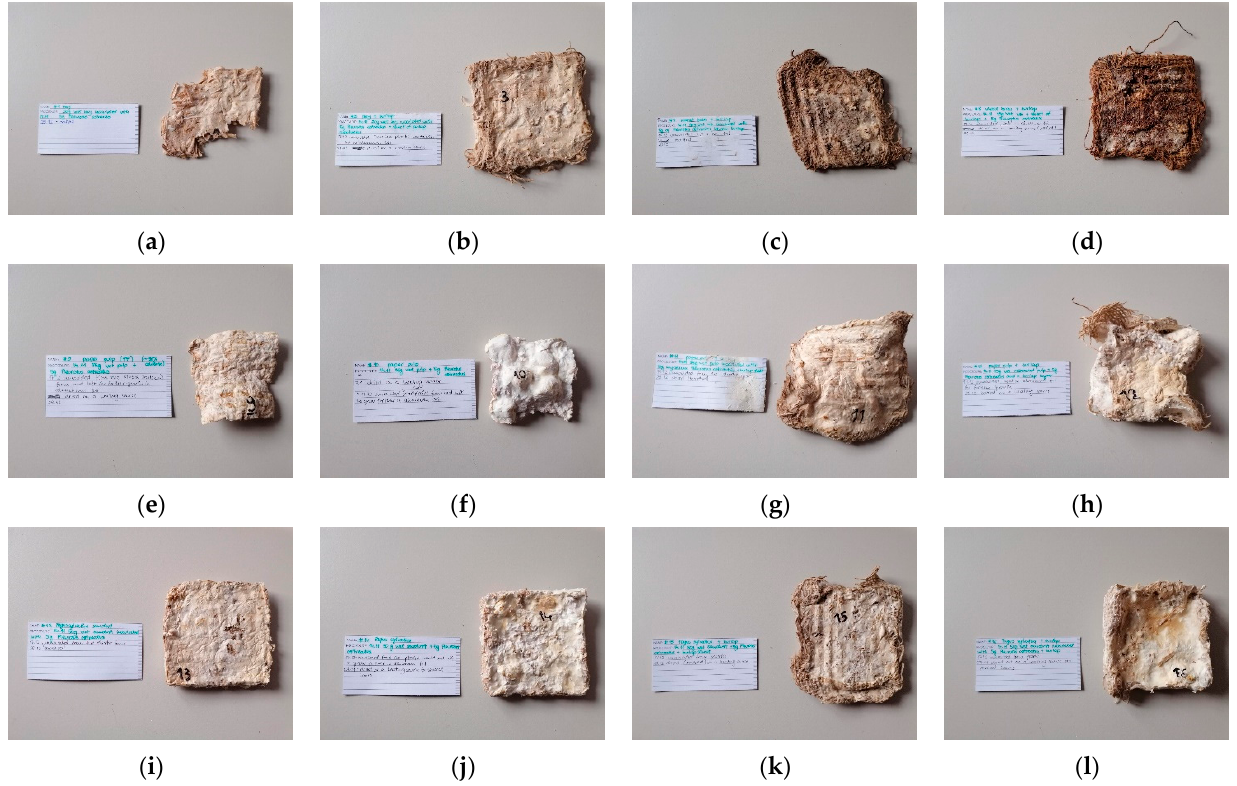
Figure 5. Samples of growth compatibility of Pleurotus ostreatus with straw, wheat bran, bleached cellulose pulp and beech sawdust: ( a ) ST-PO-01; ( b ) ST-B-PO-03; ( c ) WB-B-PO-03; ( d ) WB-B-PO-04; ( e ) CS1-PO-02; ( f ) CS1-PO-03; ( g ) CS1-B-PO-04; ( h ) CS1-B-PO-05; ( i ) FS-PO-20; ( j ) FS-PO-21; ( k ) FS-B-PO-22; ( l ) FS-B-PO-23.